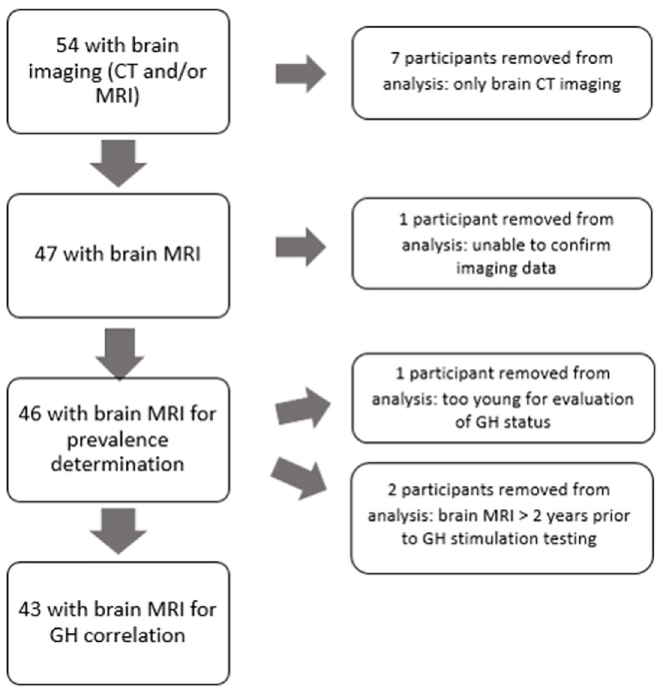
Fig 1. Inclusion/exclusion criteria flowchart. We identified 54 patients with PHP1A and GH deficiency who had brain CT and/or MRI imaging within our cohort. Of these, 47 had a brain MRI performed. One participant was excluded, as we were unable to confirm the imaging data. This resulted in 46 participants for the prevalence calculations. From these, 3 were further excluded, as they were either too young for evaluation of GH status or had a brain MRI > 2 years prior to GH stimulation testing. The remaining 43 participants were included in the GH versus CM1/LLCT correlation calculations.